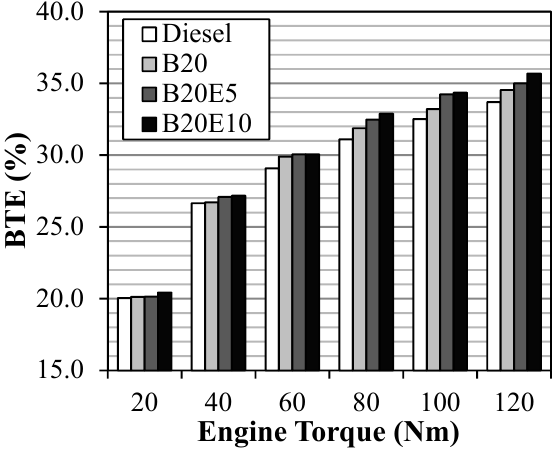
Figure 3. BTE for the tested fuels at different engine loads.